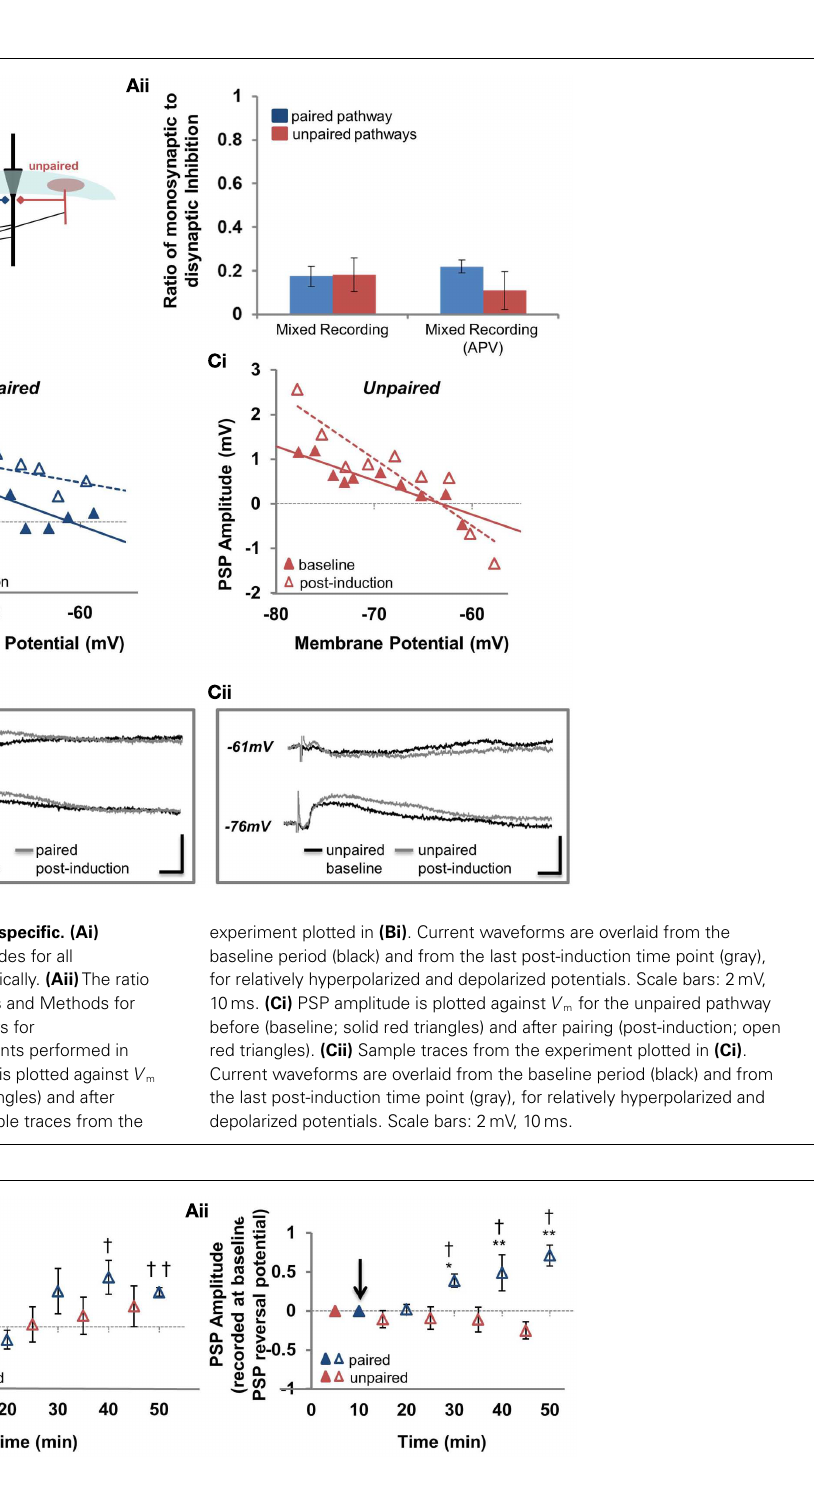
open triangles represent recordings following plasticity induction. PSP– V m curves were constructed at five time points, alternating between unpaired and paired pathways. Each of the five time points at the paired pathway were compared to the corresponding time point from the unpaired pathway. * Denotes statistical significance from unpaired pathway ( p < 0.05). † Denotes statistical significance from baseline ( p < 0.05). Paired activity denoted by